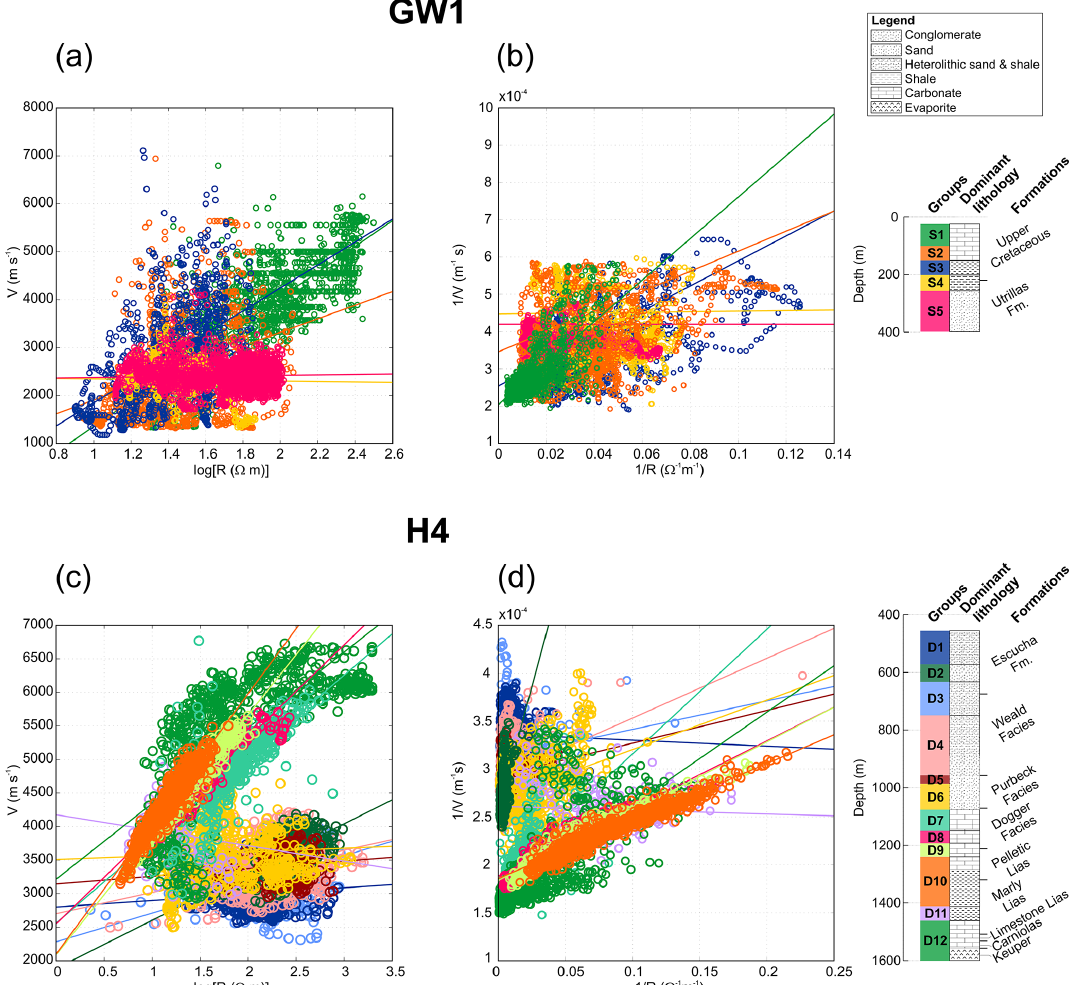
Figure 6. Resistivity vs. Velocity for the GW1 and H4 well logs. The resistivity–velocity log pairs were grouped based on their depth and their relative behaviour: the GW1 log data were divided into five groups (S-groups) and the H4 log data into 12 groups (D-groups). Two empirical relations were calculated for each group: (i) ER1, a linear regression of V vs. log( R ) ( a and c ) and (ii) ER2, a linear regression of 1 /V vs. 1 /R ( b and d ). The figure shows the dominant lithology of all the S- and